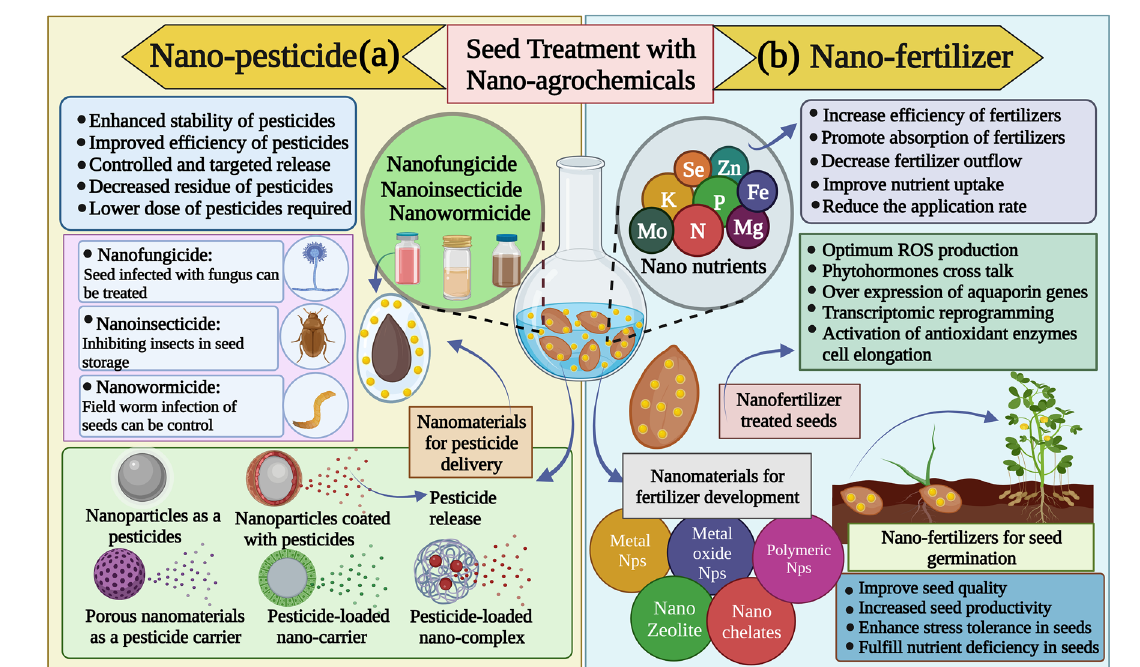
Fig. 2 Role of nanoagrochemicals and nanofertilizers in seed treatment. a Characteristics of nanopesticides, such as enhanced stability, control, and targeted delivery of agrochemicals, assist the seed in effectively protecting itself from pathogens and pests during germination. b Nanoferti- lizers compositions (Se, Zn, N, P, K, Mo, etc.) providing the nutrient-rich element for enhanced seed protection, enhanced stress tolerance, and fulfilling nutrient deficiency in the soil for the effective seed